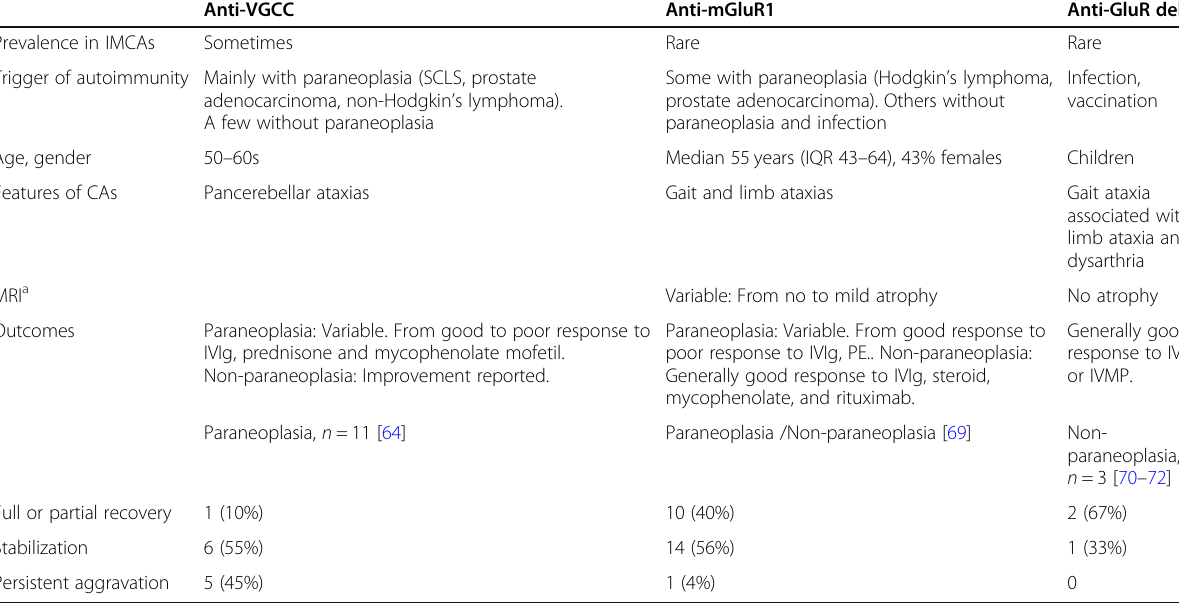
Table 1 Clinical profiles of anti-VGCC, anti-mGluR and GluR delta antibodies-associated cerebellar ataxias